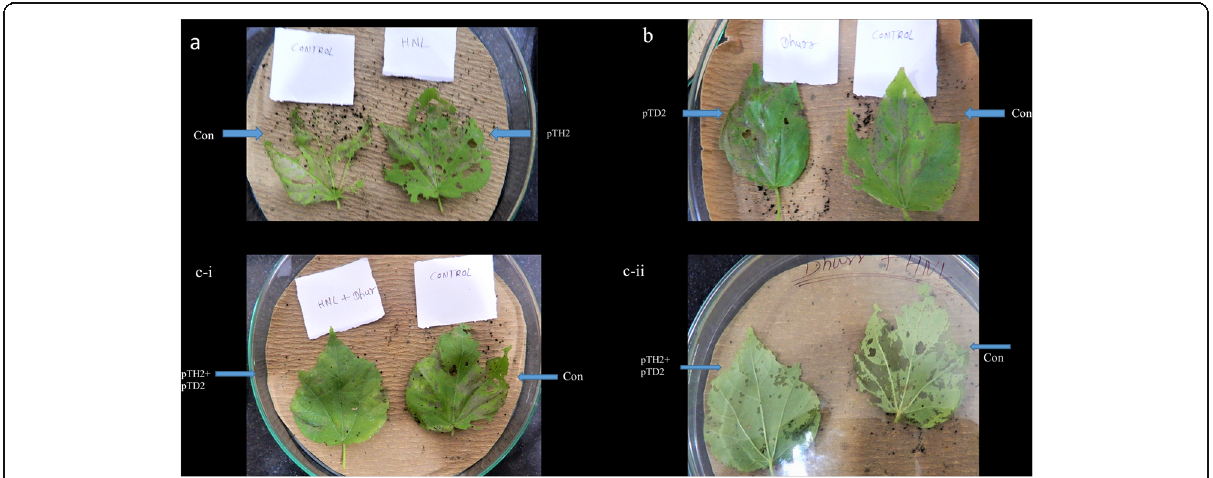
Fig. 9 Damage caused till the 8th day of feeding, Con: control (TRV1: TRV2), a pTH2 infiltrated, b pTD2 infiltrated, c -i pTH2+ pTD2 co-infiltrated (top view), c- ii pTH2 + pTD2 co-infiltrated (underside